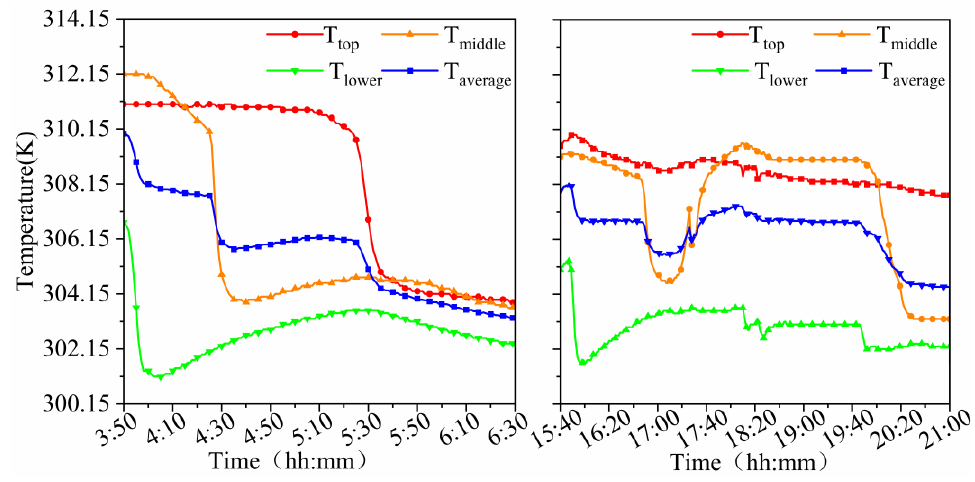
Figure 8. Temperature change of HST under different control strategies: RS-CON ( left ) and HST- CON ( right ).